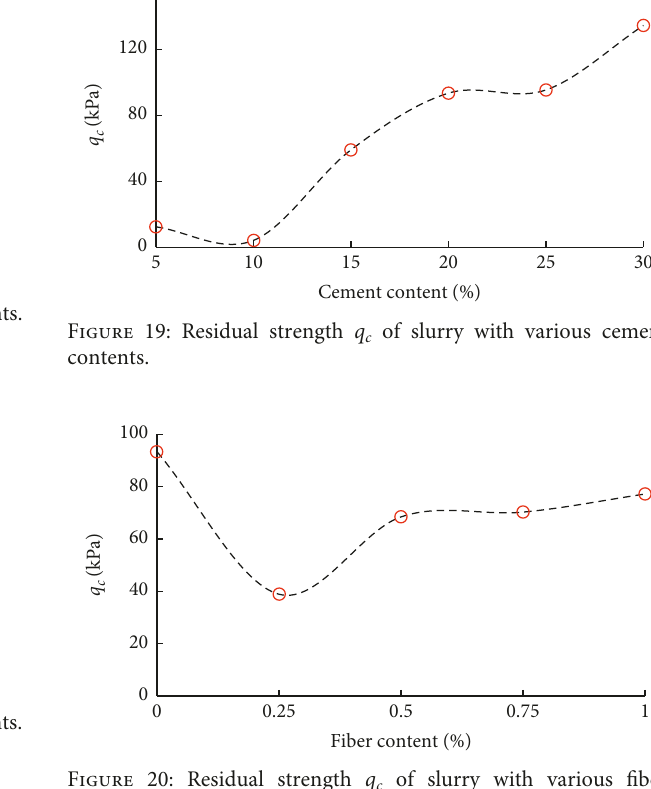
c of slurry with various fiber